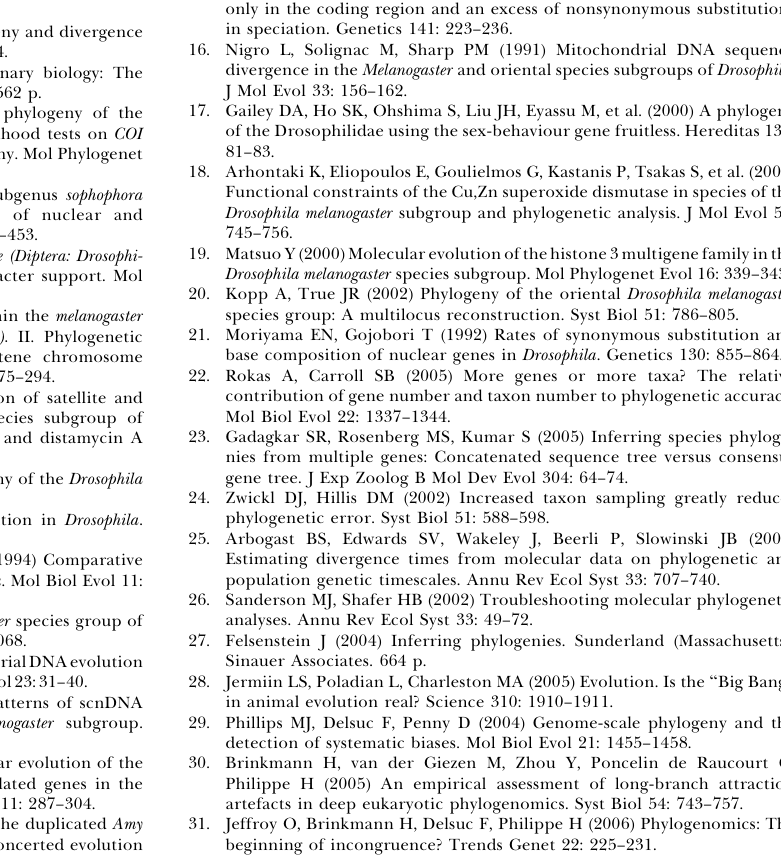
Figure S9. Significance of Incongruence under RY Coding and F81 Model